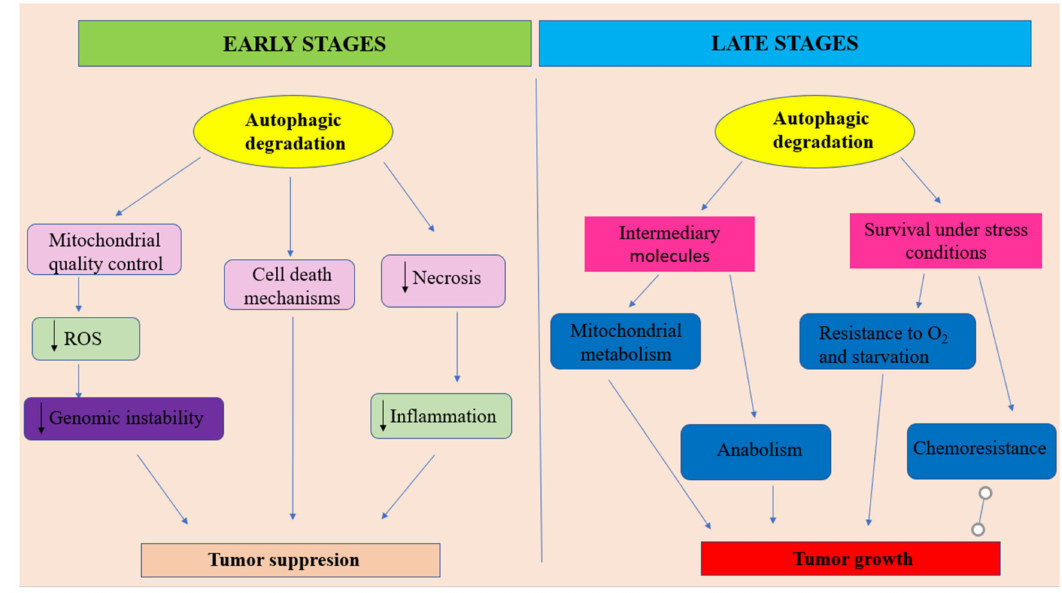
Figure 2. The dual character of autophagy in oral